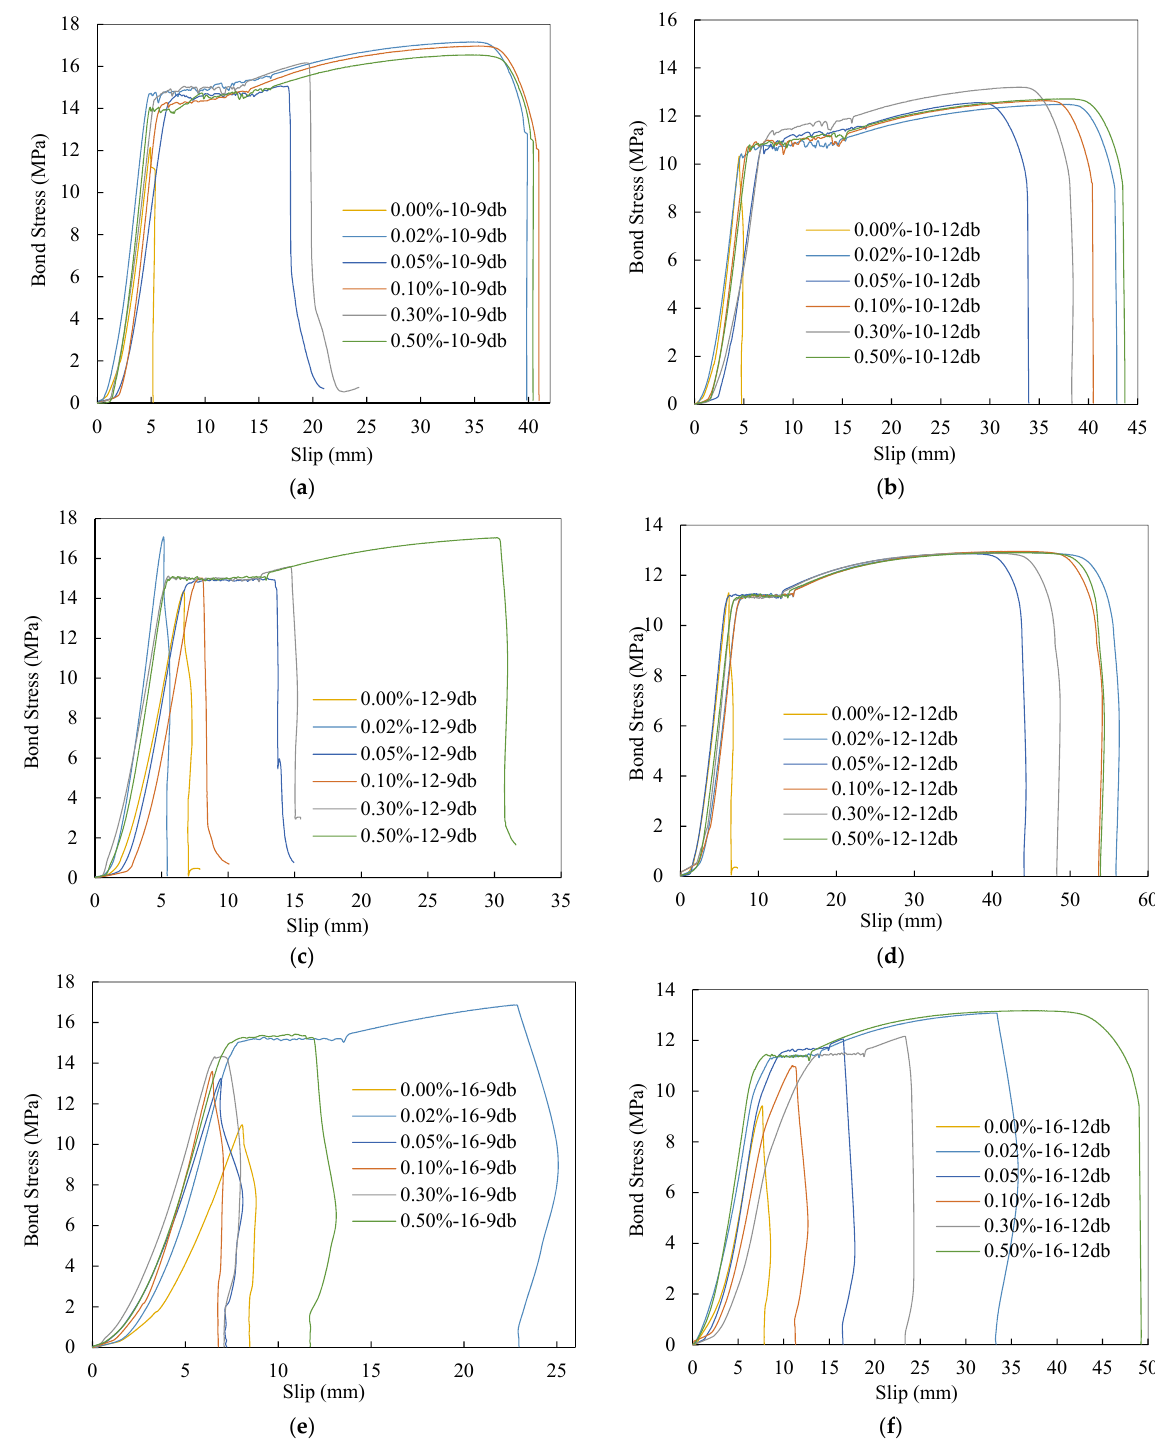
Figure 9. Slip behavior of specimens versus bond stress: ( a ) d b = 10 mm with L d = 90 mm; ( b ) d b = 10 mm with L d = 120 mm; ( c ) d b = 12 mm with L d = 108 mm; ( d ) d b = 12 mm with L d = 144 mm; ( e ) d b = 16mm with L d = 144 mm; ( f ) d b = 16mm with L d = 192